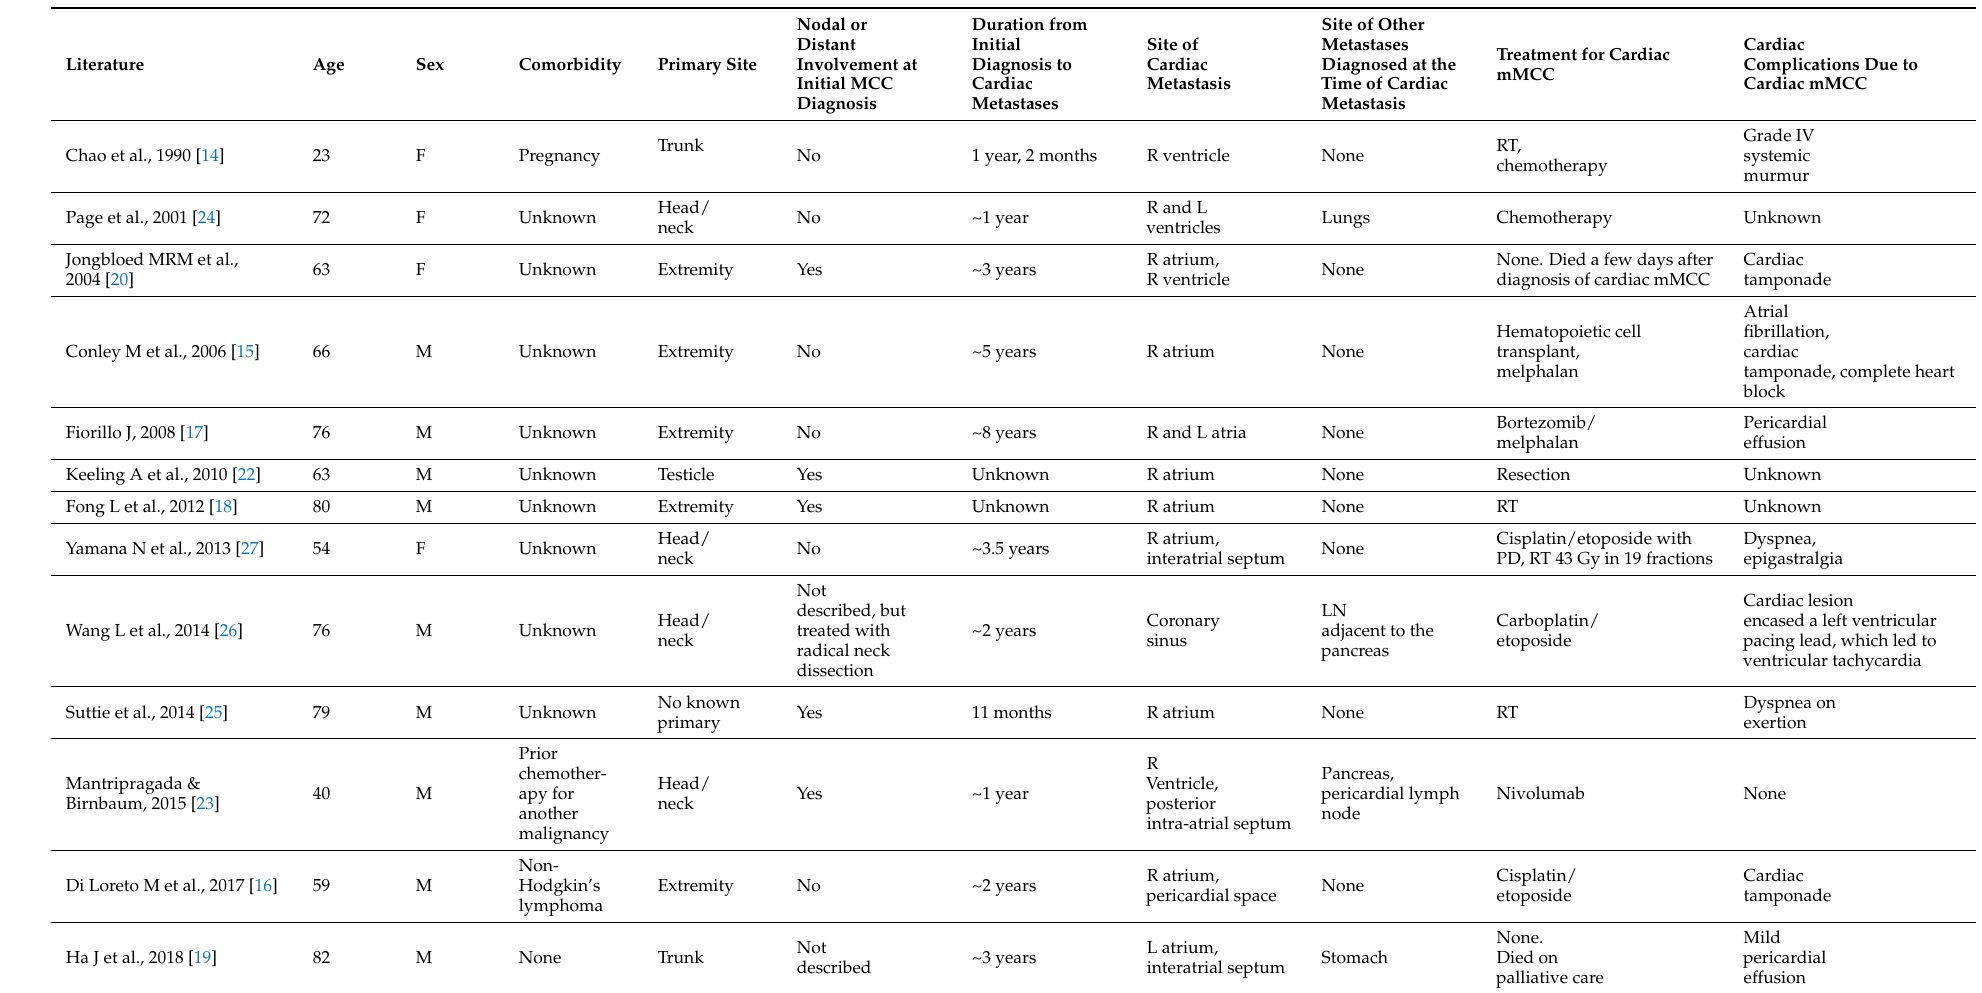
Table 4. Summary of 14 previously published